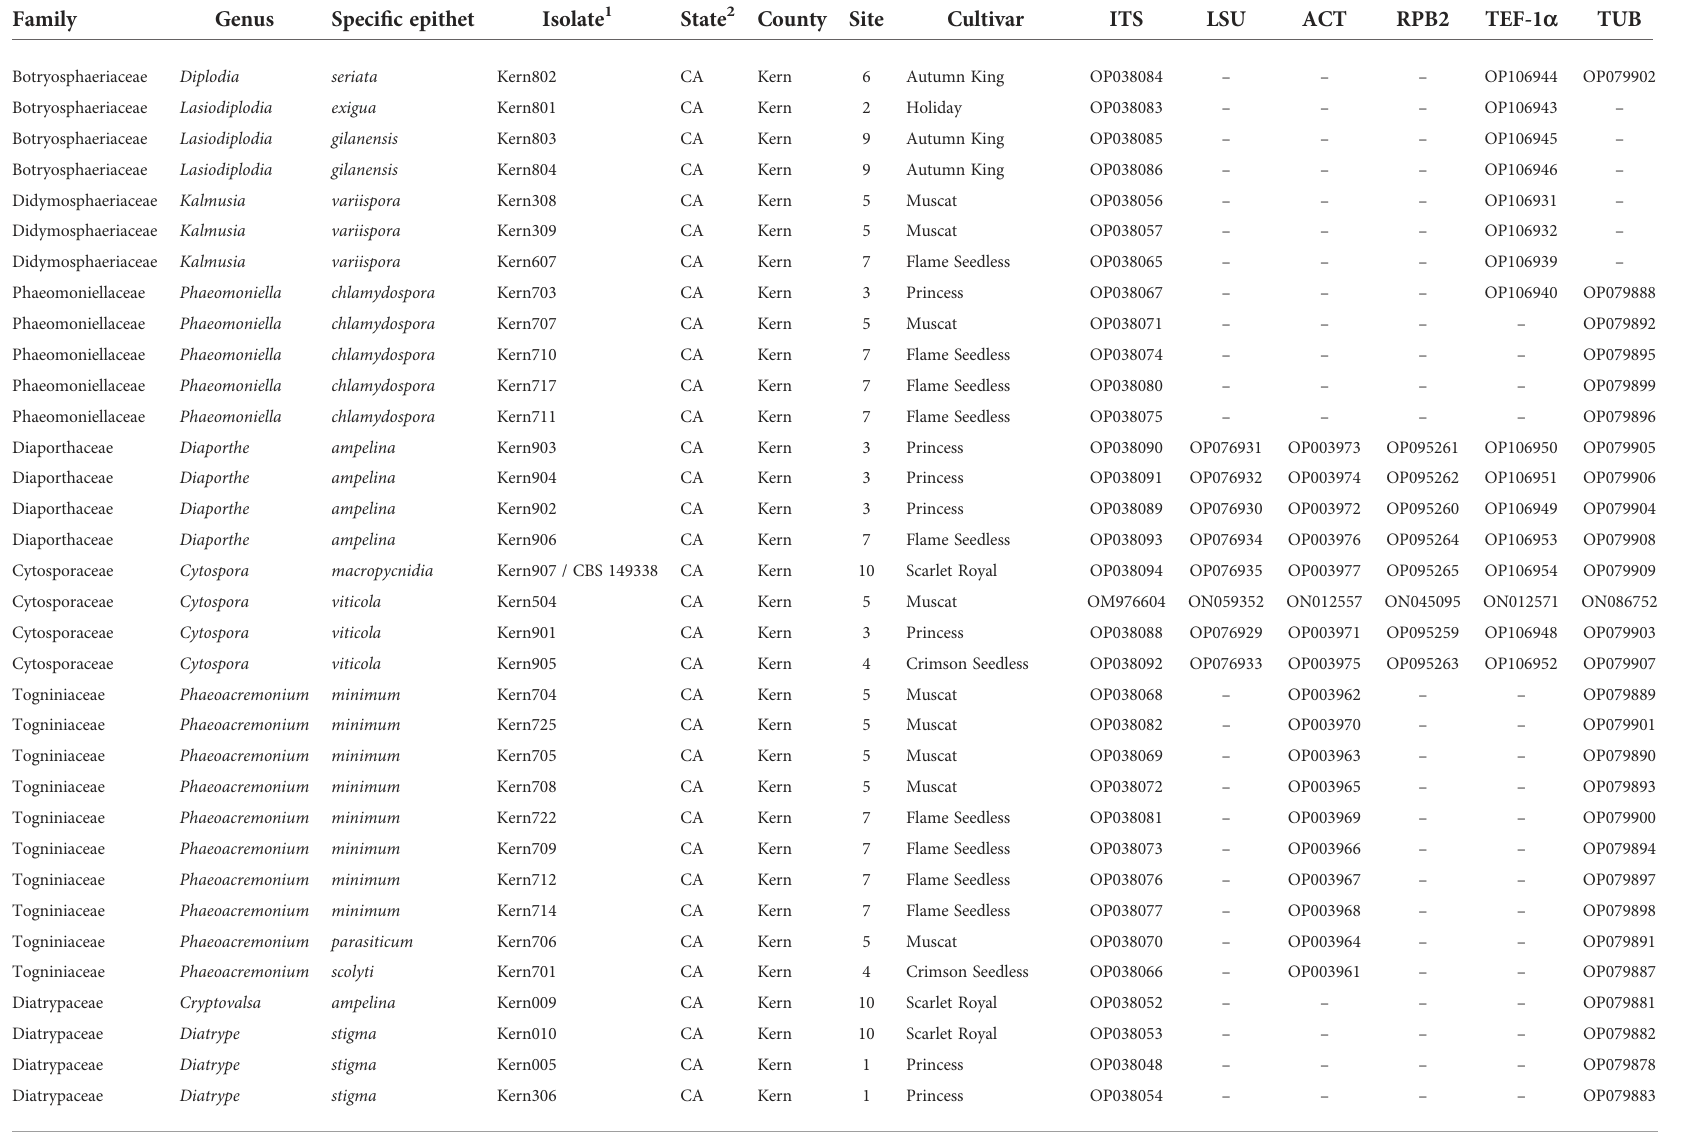
TABLE 1 List of isolates obtained from grapevine ( Vitis vinifera ) with wood symptoms of trunk diseases in California table grapes and Washington wine grapes, and associated GenBank accession numbers.